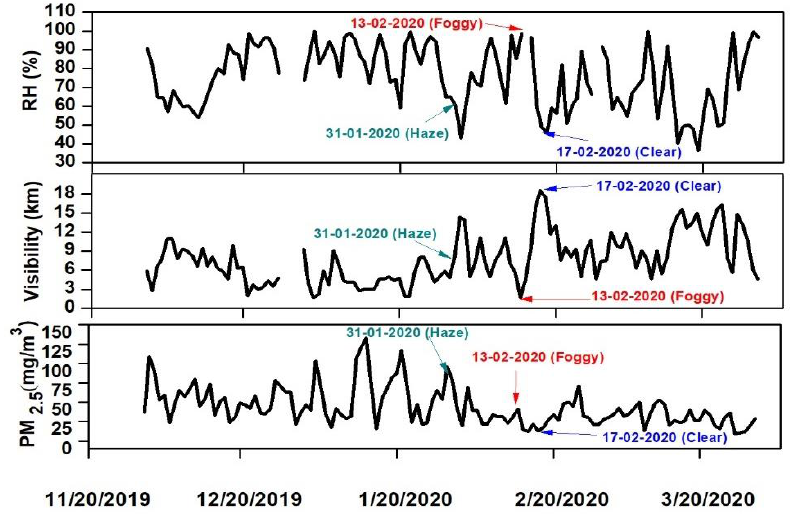
Figure 2. Time series for relative humidity (RH%), visibility, and PM 2.5. Table 2. Statistics of meteorological parameters in different conditions.